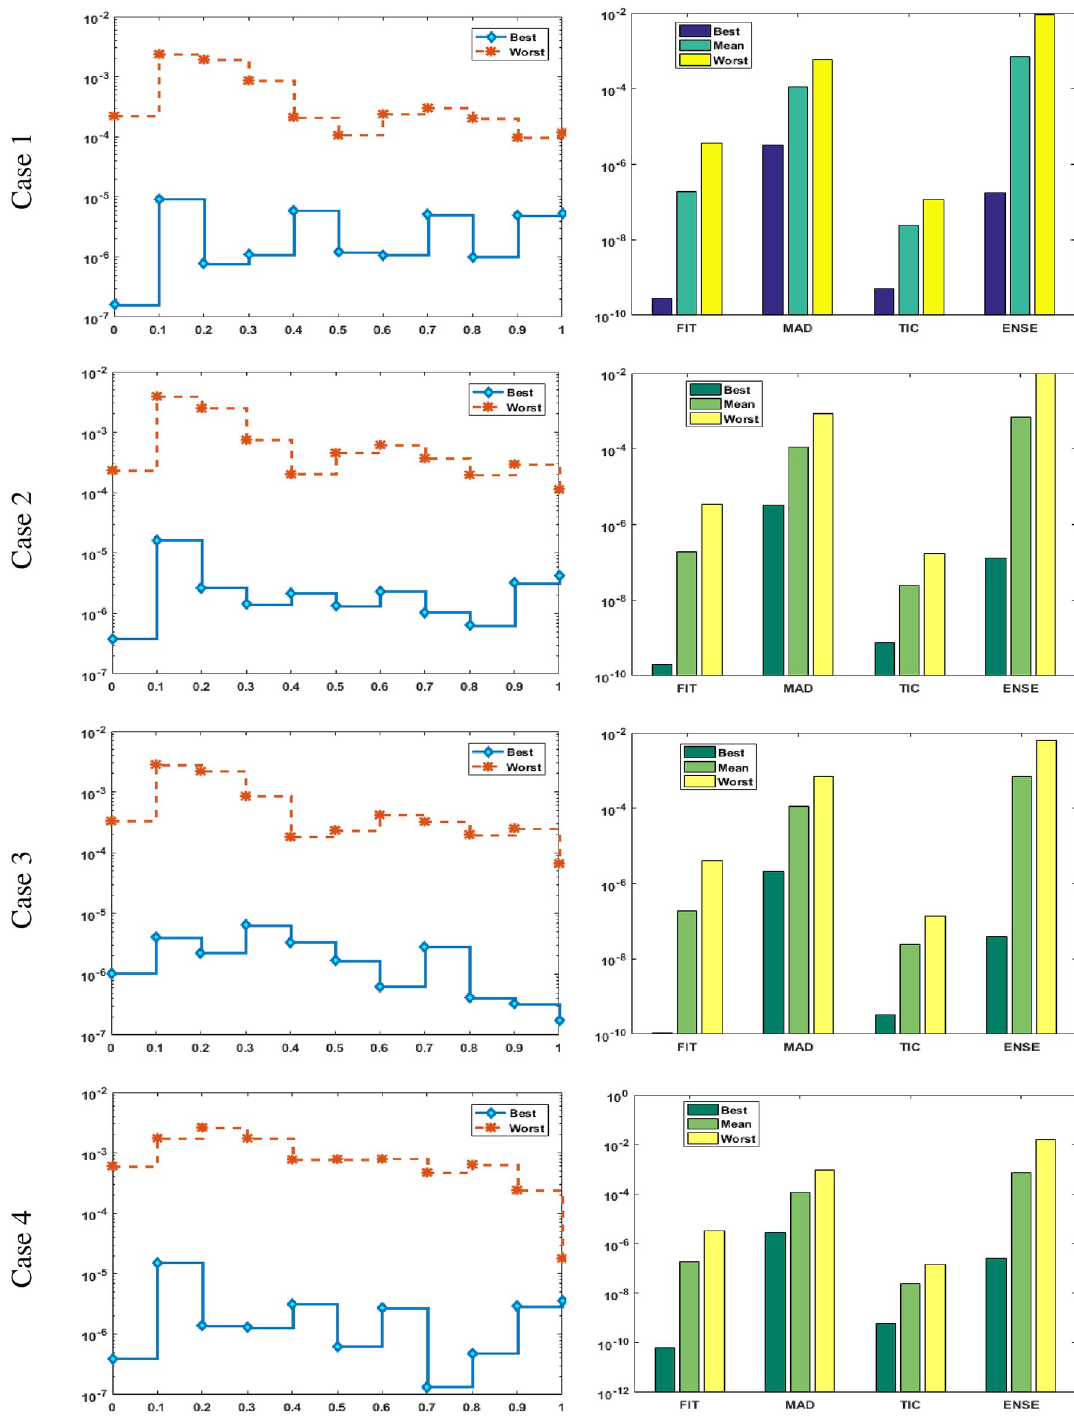
Fig 4. Absolute error and performances for each case of problem 1.